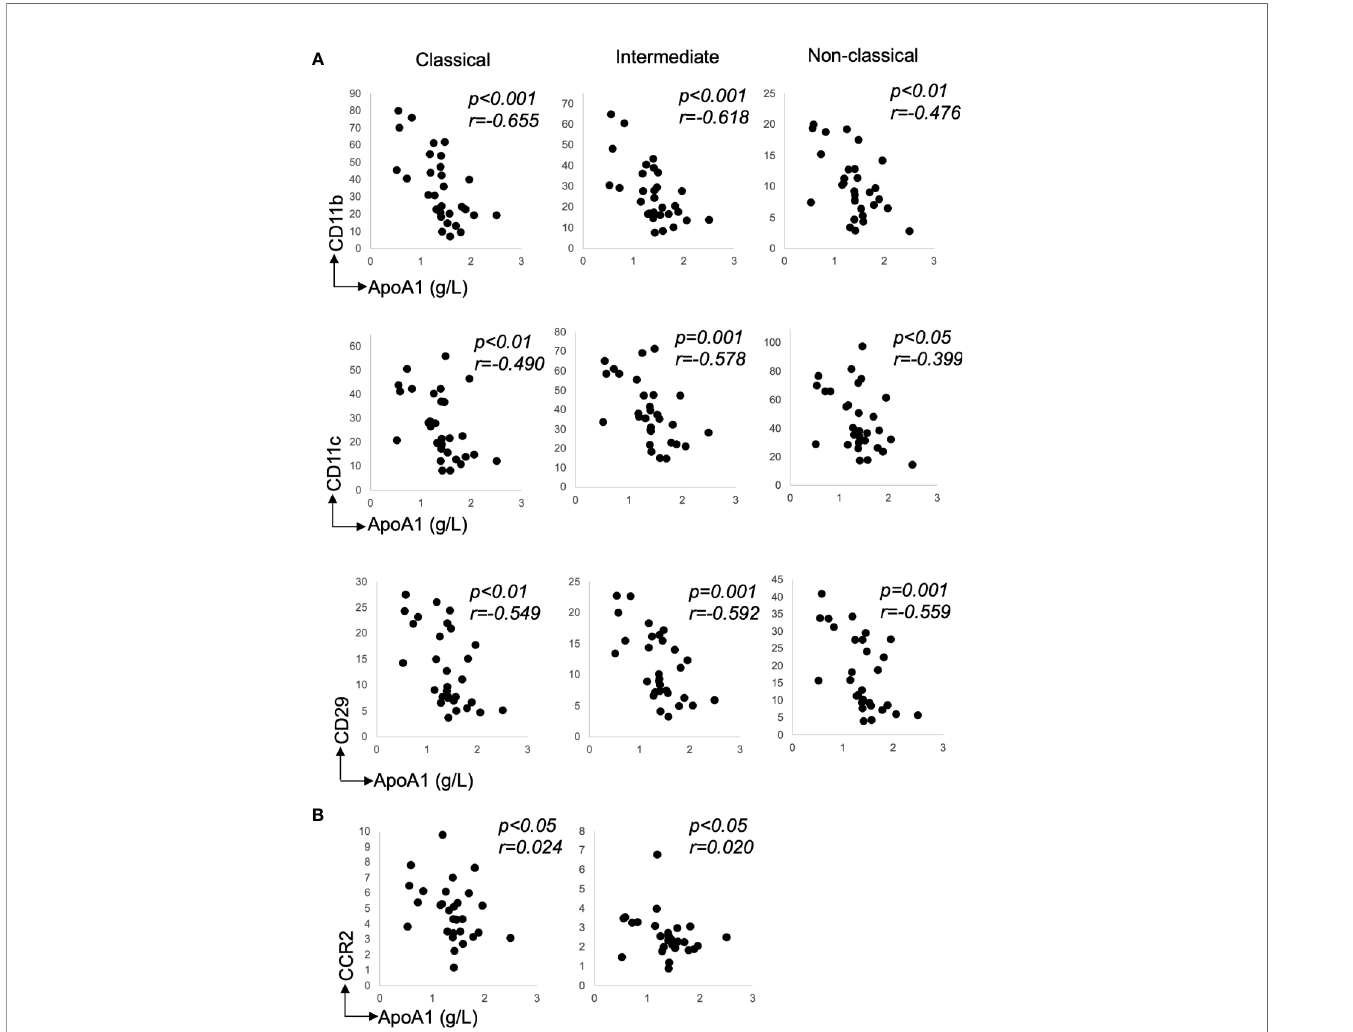
FIGURE 3 | Recruitment marker expression relative to lipid levels. (A) Classical, Intermediate and Non-classical correlations for chemokine receptor, CD11b, CD11c, and CD29 with ApoA1, n=30 (B) Classical and Intermediate correlations for chemokine receptor, CCR2 with ApoA1, n=30. Data presented as scatter plots. The statistical signi fi cance of correlation was determined by Spearman ’ s rank correlation. All tests were two-tailed. r represents correlation coef fi cient; p represents level of signi fi cance and N.S. represents non-signi fi